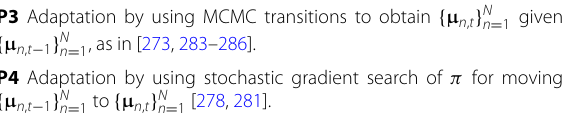
P3 Adaptation by using MCMC transitions to obtain { μ n , t } N n = 1 given } N { μ n , t − 1 n = 1 , as in [273, 283–286]. P4 Adaptation by using stochastic gradient search of π for moving {